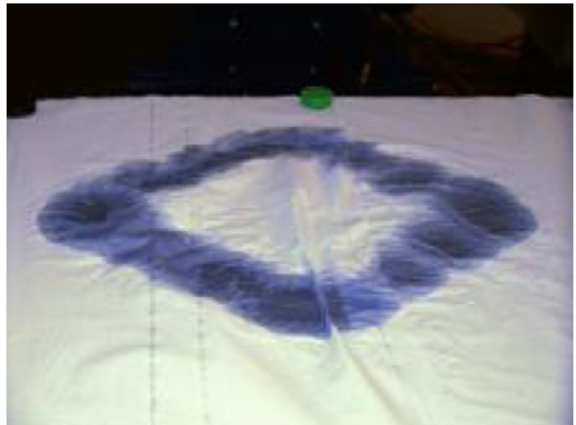
Figure 10. Printed Dag pattern showing local directed spray (Jerko Spruesystems).